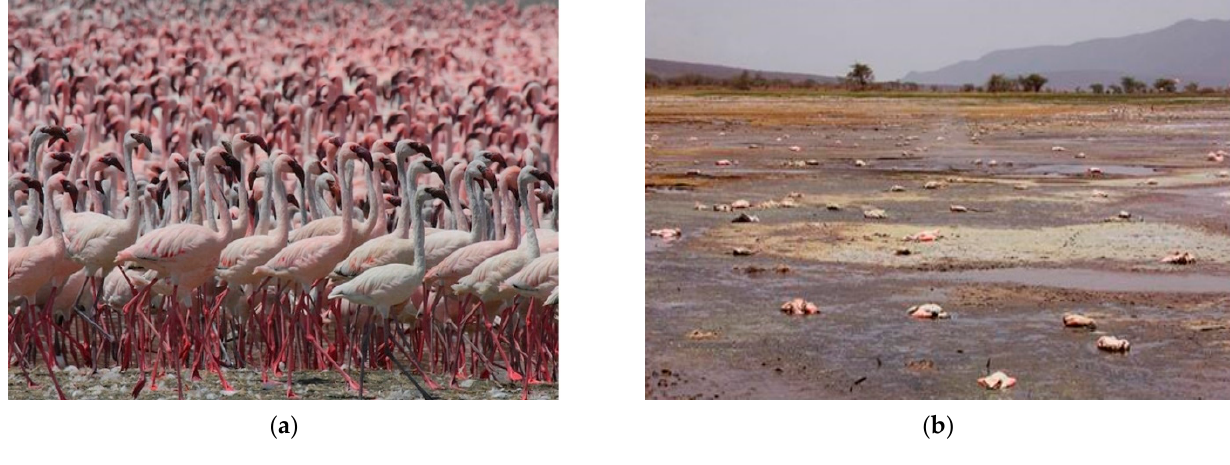
Figure 4. Lesser flamingos at the Kenyan Lake Bogoria ( a ) a flock wading ashore (photo by Steve Garvie. Source: Riley [92]), and ( b ) massive die-off in July 2008 [93]. Table 2. Microcystin and anatoxin-a-related massive mortalities of lesser pink flamingos in alkaline- saline (soda-rich and schizohaline) lakes of East African Community in comparison with cyanotoxin-related bird mortality reports from other countries.